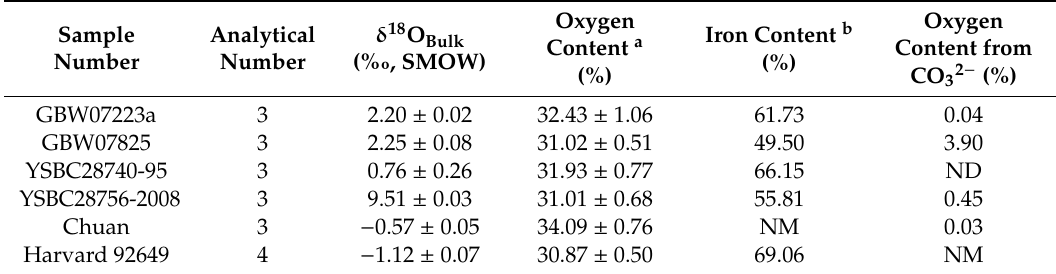
Table 2. Oxygen isotopes and oxygen content data in bulk rock